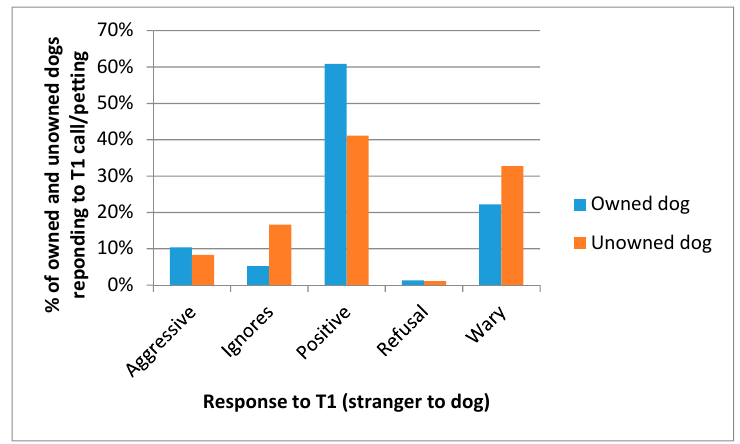
Figure 9. Responses of owned and unowned dogs to being called over and petted by T1s.